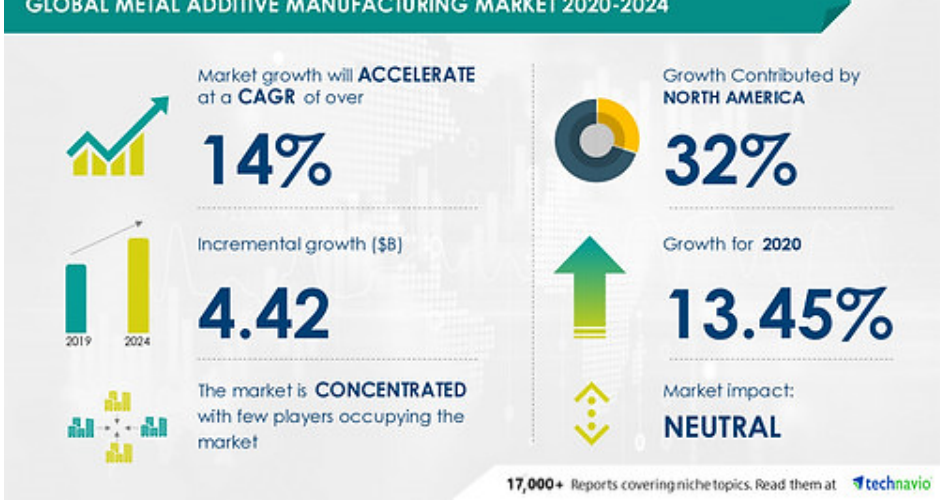
Figure 10. Technavio’s latest market research report titled ‘Metal Additive Manufacturing Market by Application and Geography-Forecast and Analysis 2020–2024 (cid:48) [75]. (CAGR = Compound Annual Growth